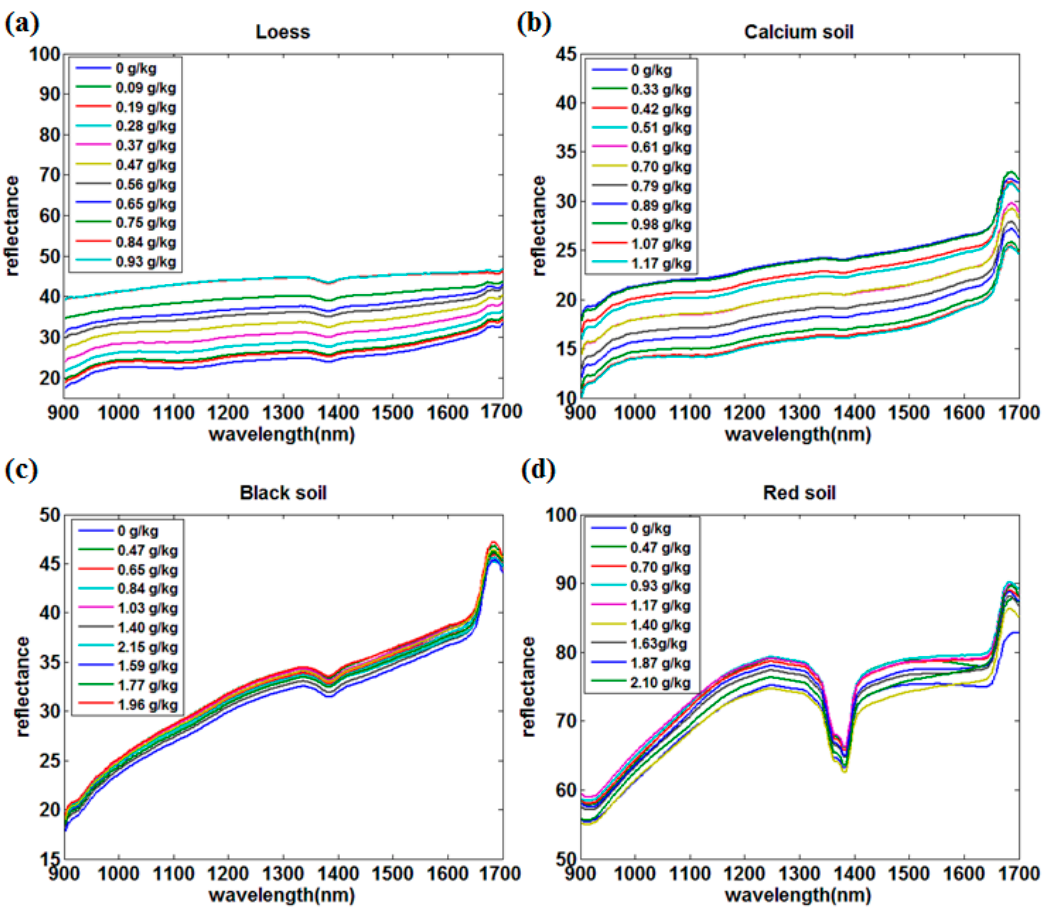
Figure 2. The average NIR spectral curves of four kinds of soils at each nitrogen concentration. ( a ) Loess; ( b ) Calcium soil; ( c ) Black Soil; ( d ) Red